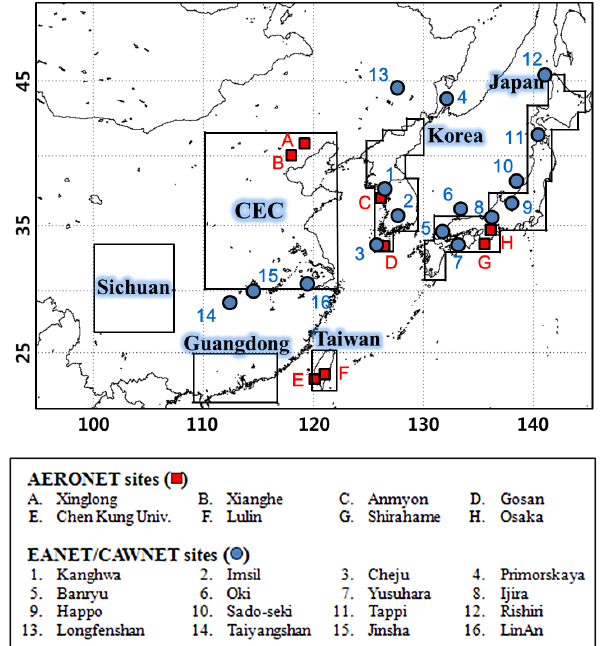
Fig. 2. Model domain of MM5 and CMAQ model simula- tions and the locations of 8 NASA AERONET sites and 16 EANET/CAWNET sites in the East Asian domain. Also shown are the central East China (CEC) region, the Sichuan Basin, the Guang- dong region, Korea, Japan, and